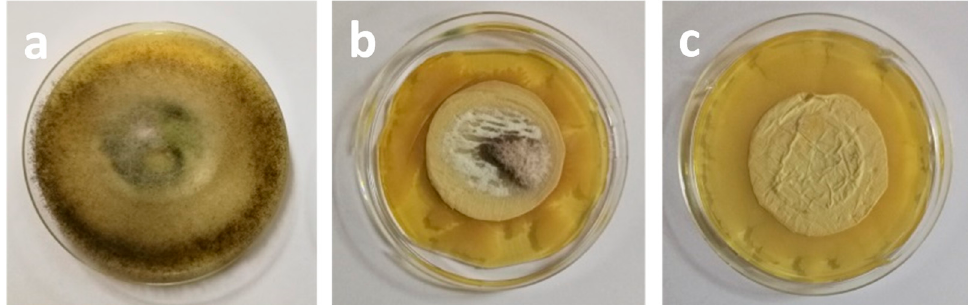
Figure 5. Digital images of the growth of P. chlamydospora on the fibrous materials: ( a ) PHB, ( b ) TiO 2 - in -PHB, and ( c ) TiO 2 - on -PHB [108].